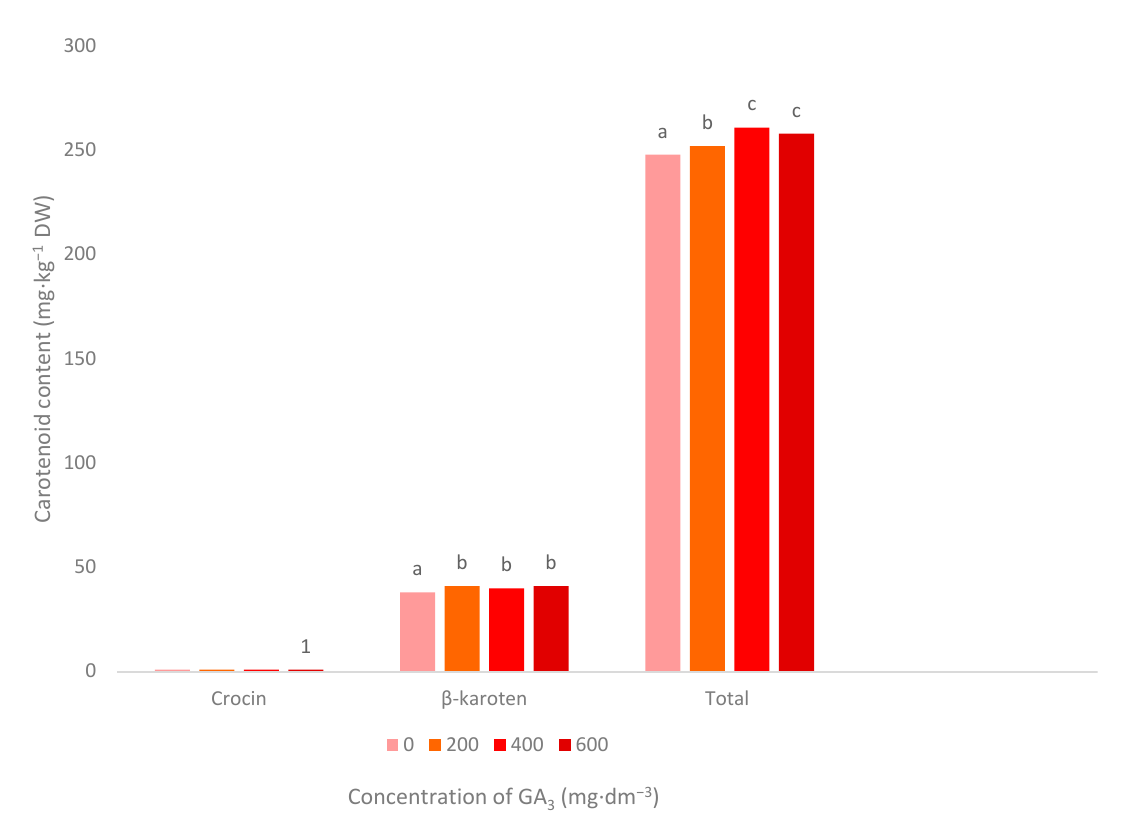
Figure 4. Carotenoid content of the Crocosmia × crocosmiiflora ‘Lucifer’ tubers after application of GA 3 . Means followed by the same letter do not differ significantly at α = 0.05.